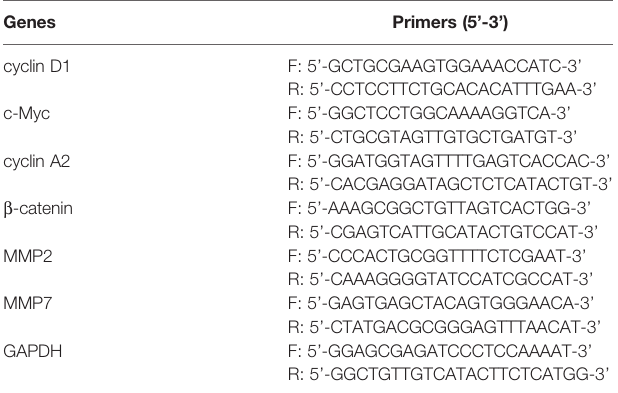
TABLE 1 | Primers used in qRT ‐